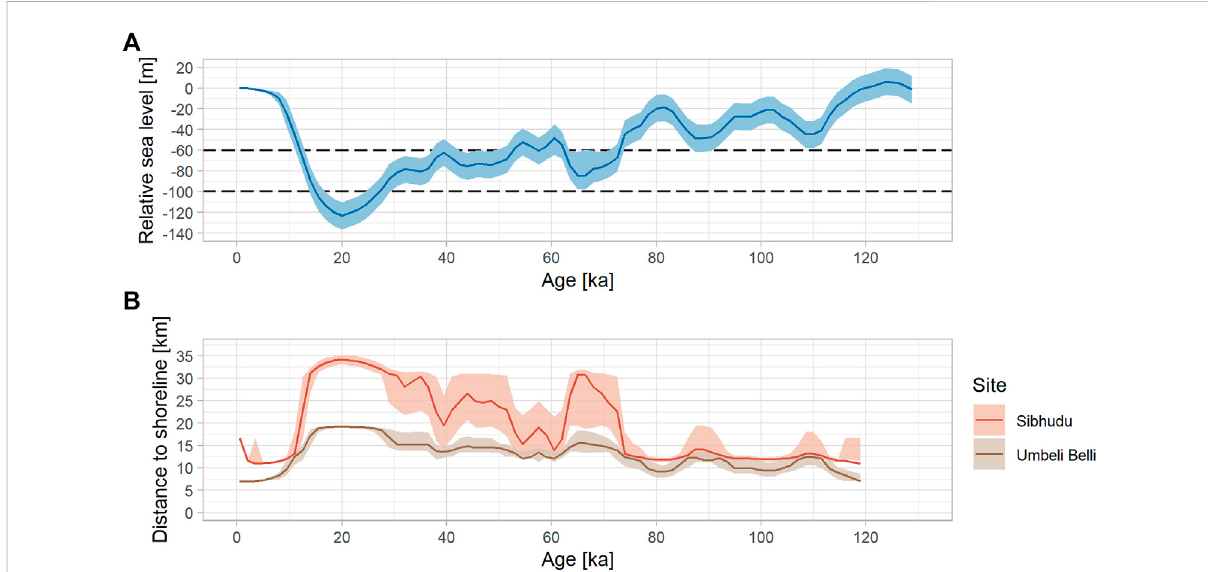
FIGURE 2 Input and output of the GIS model. (A) Sea level curve by Waelbroeck et al. (2002) with error margins. The dashed lines indicate the depths of aeolianiteshorelinepositionsat − 60and − 100 m. (B) Shorelinedistancevariationoftwoexemplarysites,SibhuduandUmbeliBelli,inresponsetosea level lowering. The error margins are derived from the uncertainties of the sea level